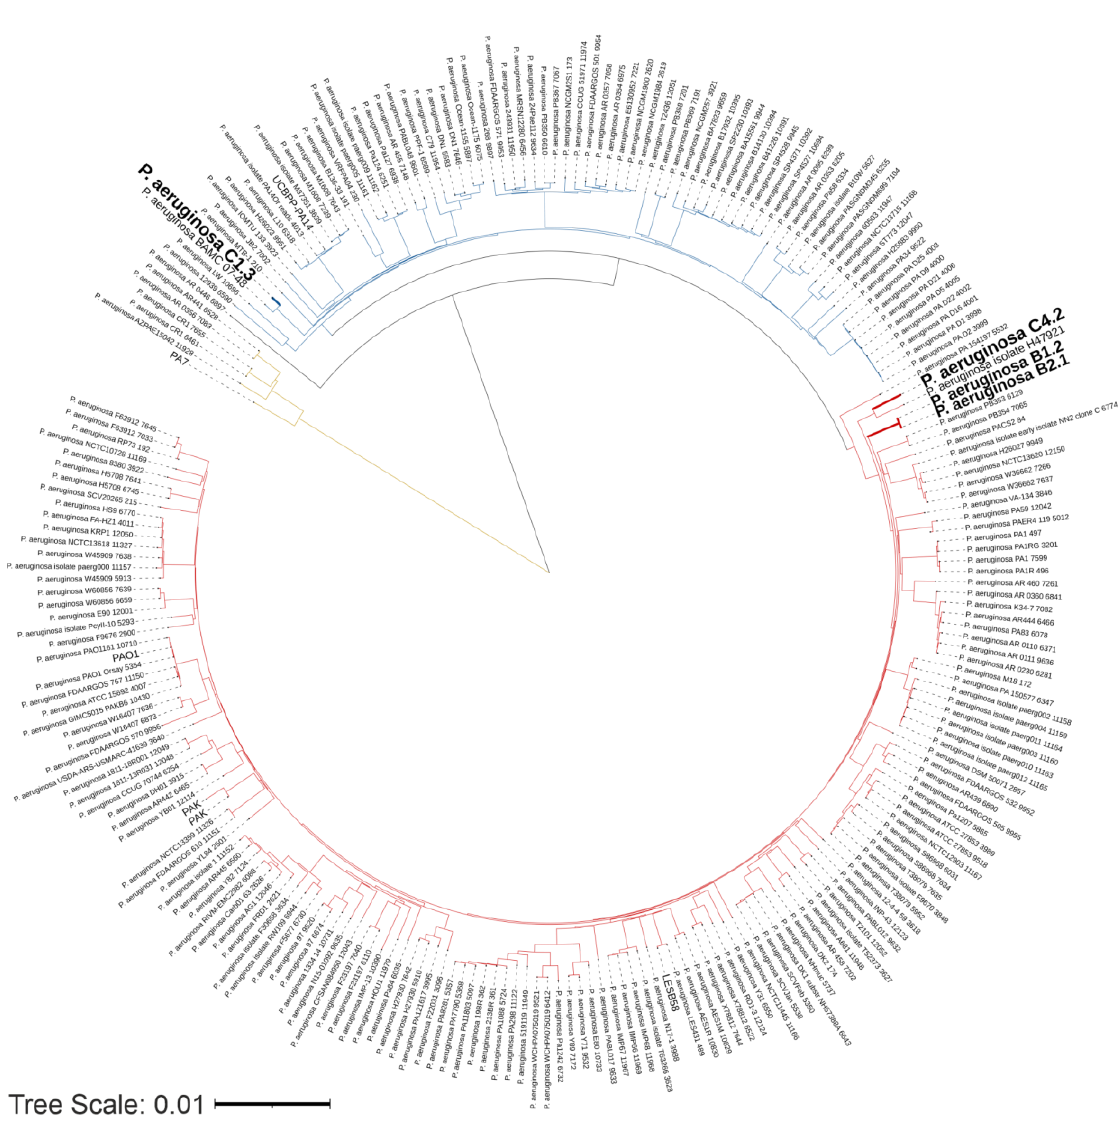
Figure 5. Phylogenetic analysis of P. aeruginosa WM isolates. Circular tree built with the four WM isolates and 233 P. aeruginosa complete genome sequences taken from the Pseudomonas Database, including popular/reference strains PAO1, LESB48, UCBPP-PA14 and PA7 [58,59]. Three distinct clusters are visible and additionally colored in yellow, blue and red.